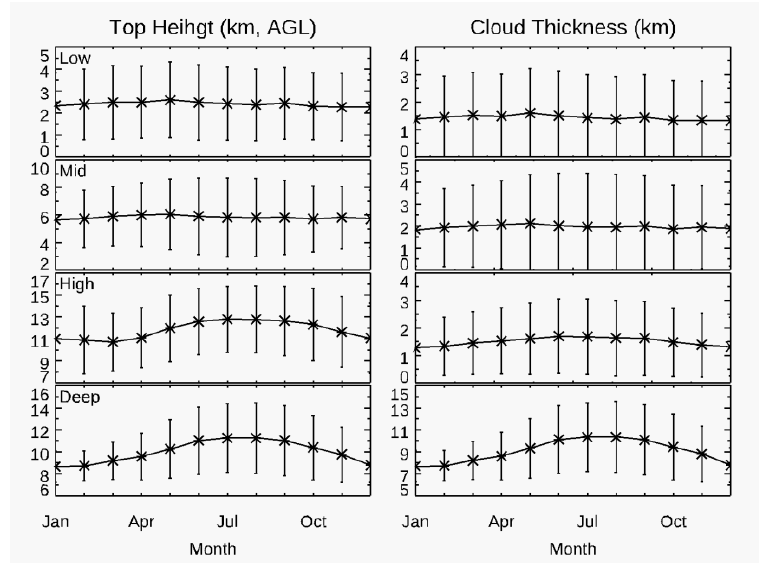
Figure 9. Time series of monthly averaged cloud-top height and cloud thickness for low-level, mid-level, high-level, and deep clouds. The vertical bars represent the standard deviations of the monthly mean values.